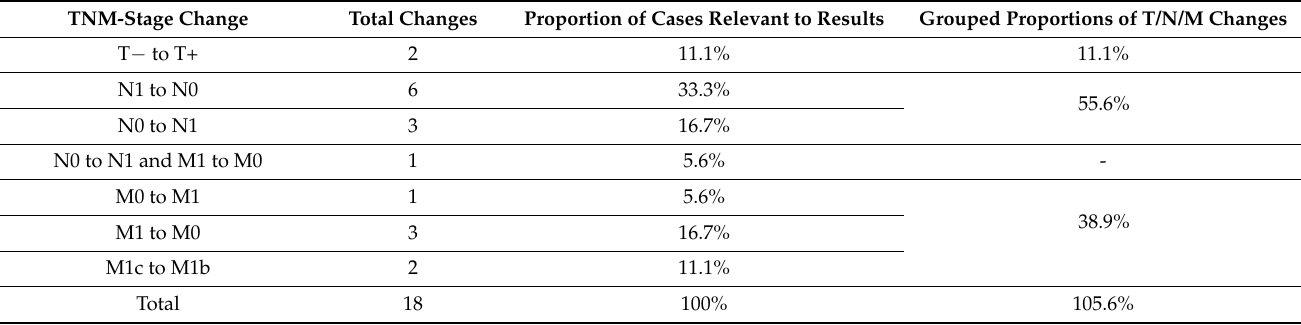
Table 10. Distribution of all 68 Ga-PSMA-PET/CT examinations relevant to the TNM